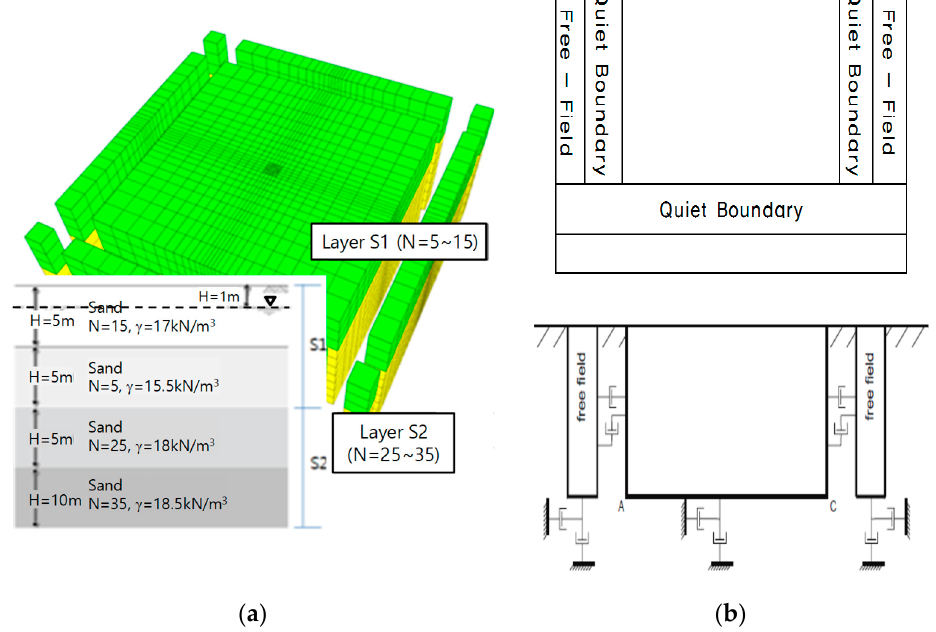
Figure 7. Numerical model and boundary conditions: ( a ) numerical model; ( b ) boundary conditions.